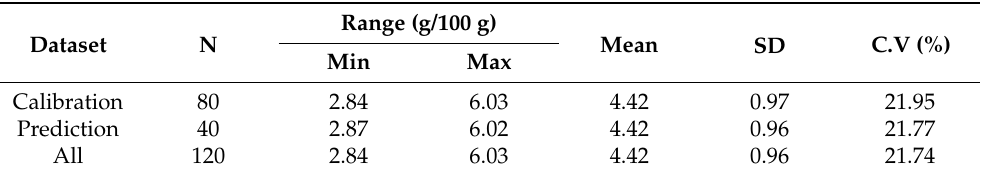
Table 1. Statistical analyses of measured fat contents in all millet samples in the calibration and prediction sets.